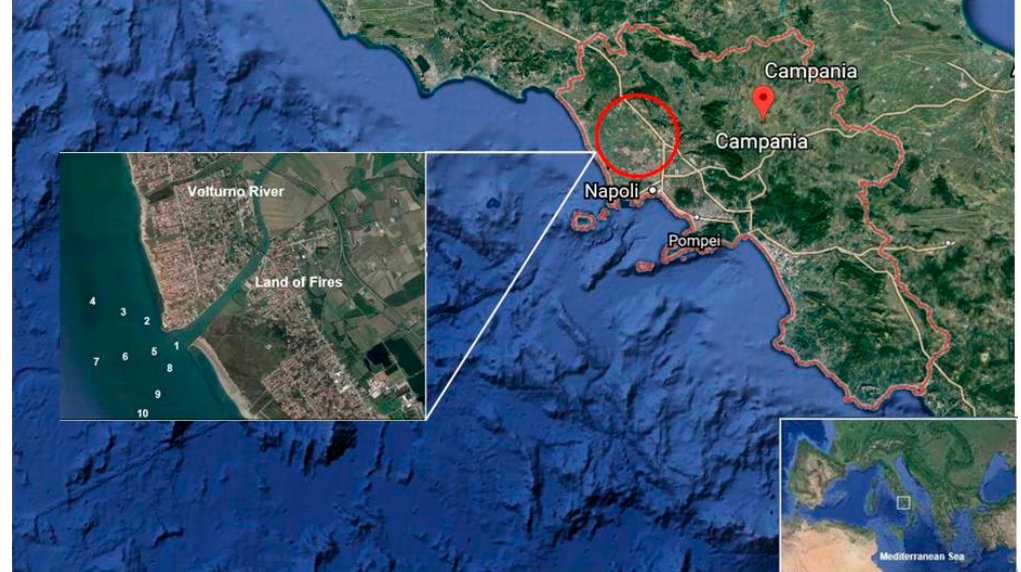
Figure 1. Map of the study area and sampling sites in the Volturno River and Estuary, Southern Italy. Source: Google Earth